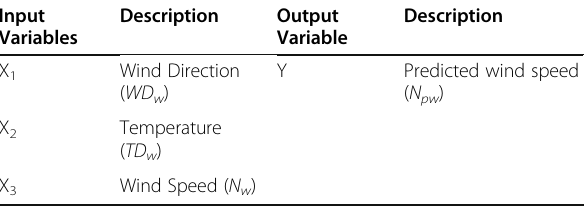
Table 1 Input and output variables of the proposed neural network model